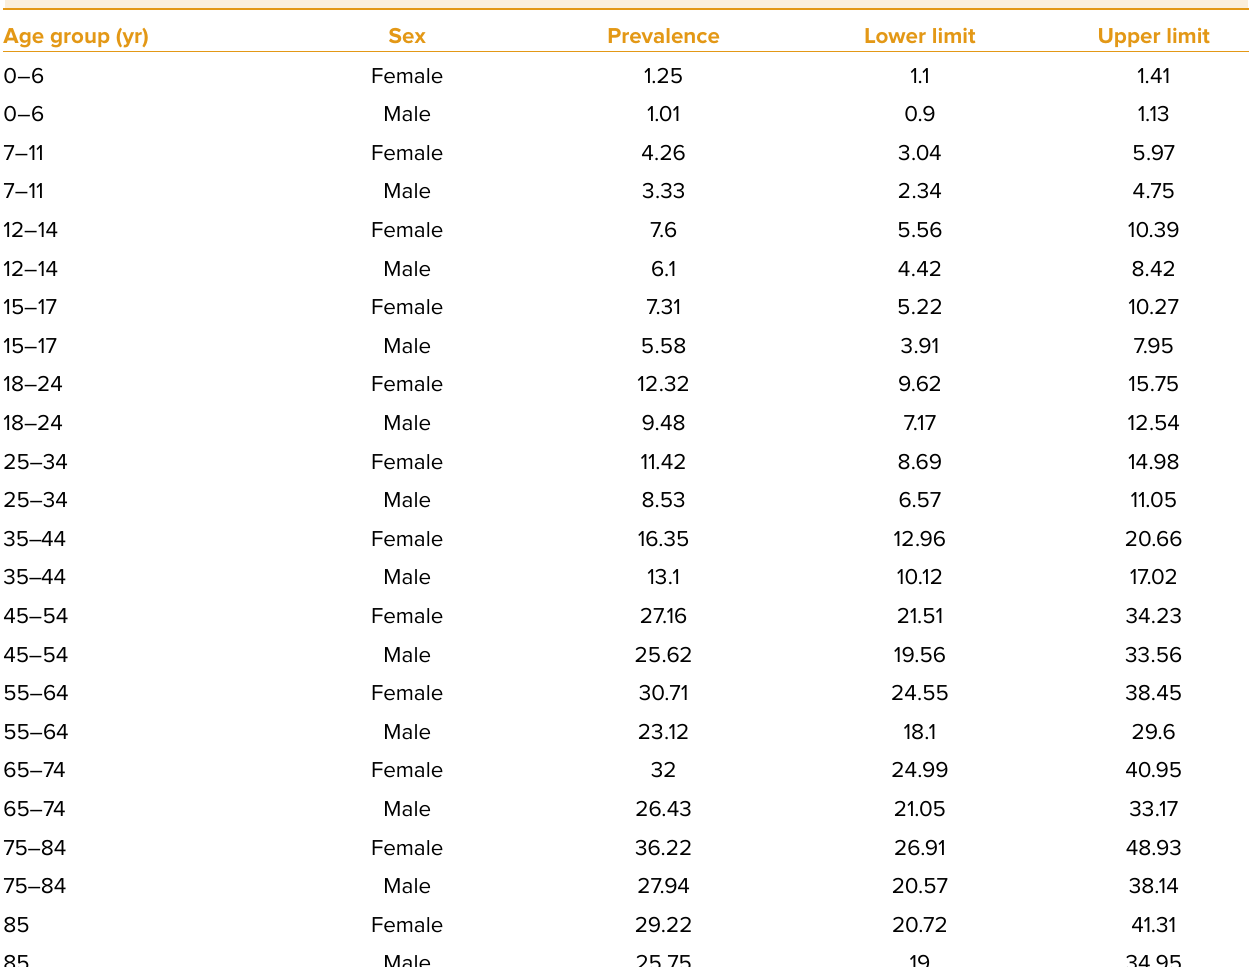
Table 2. Prevalence of refractive errors by sex and age group in year 2018.